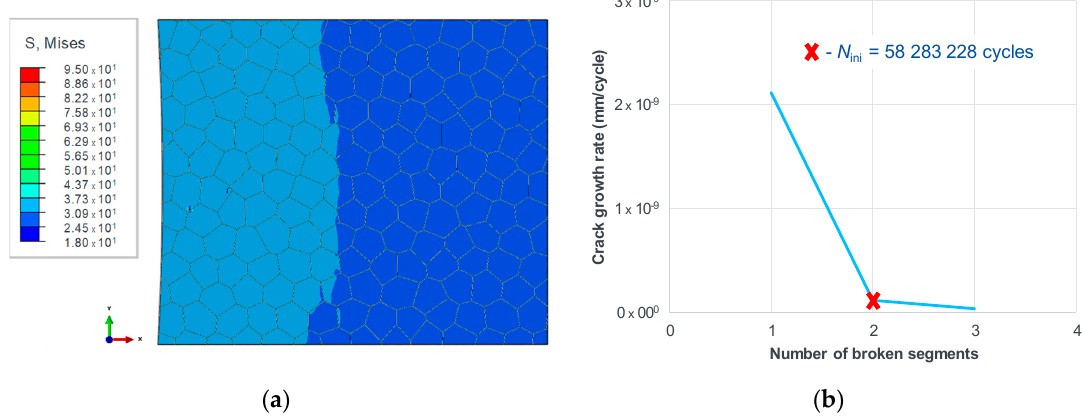
Figure 11. ( a ) Damaged microstructural model of the 1050A; ( b ) Fatigue crack growth rate of the 1050A at the end of the crack initiation stage, under 15 MPa loading stress amplitude.